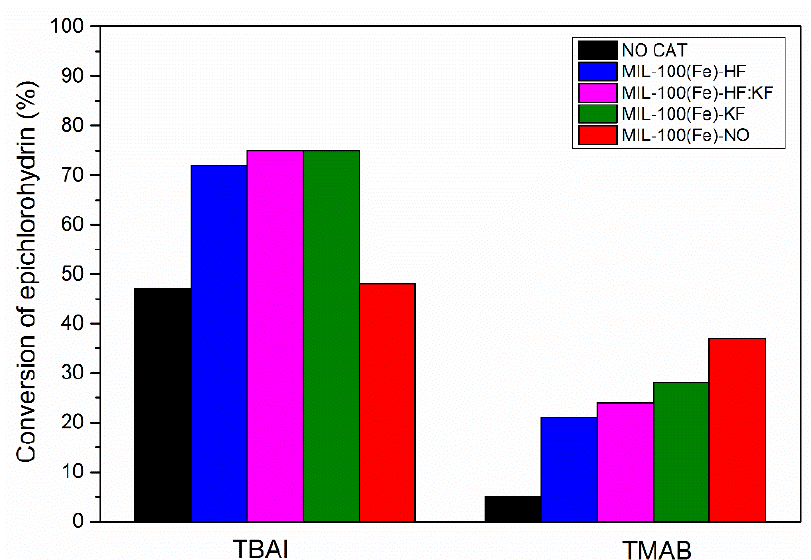
Figure 8. Catalytic reaction of CO 2 with epichlorohydrin with different MIL-100(Fe) samples as catalysts and organic halides as cocatalysts. Conditions: 97 mol.% of epichloroydrin, 0.84 mol.% of MIL-100(Fe), 1.53 mol.% of organic halide, 0.57 mol.% of mesytilene, 60 ◦ C, 15 bar CO 2 , 250 min [49]. The conversion of epichlorohydrin was based on 1 H-NMR results (chloropropene carbonate was the only product).